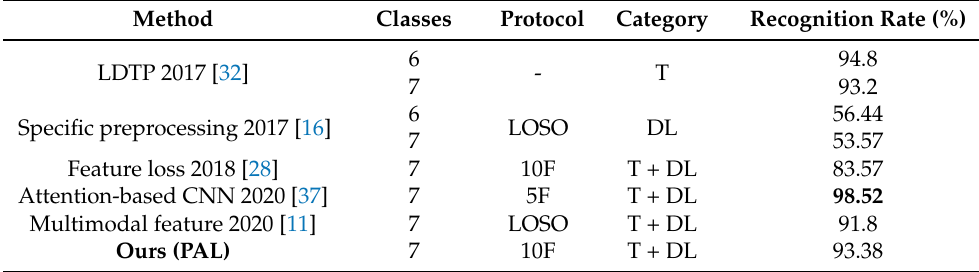
Table 5. Performance comparison with different methods on the JAFFE. Symbol “-” denotes not reported. “LOSO” denotes “Leave One Subject